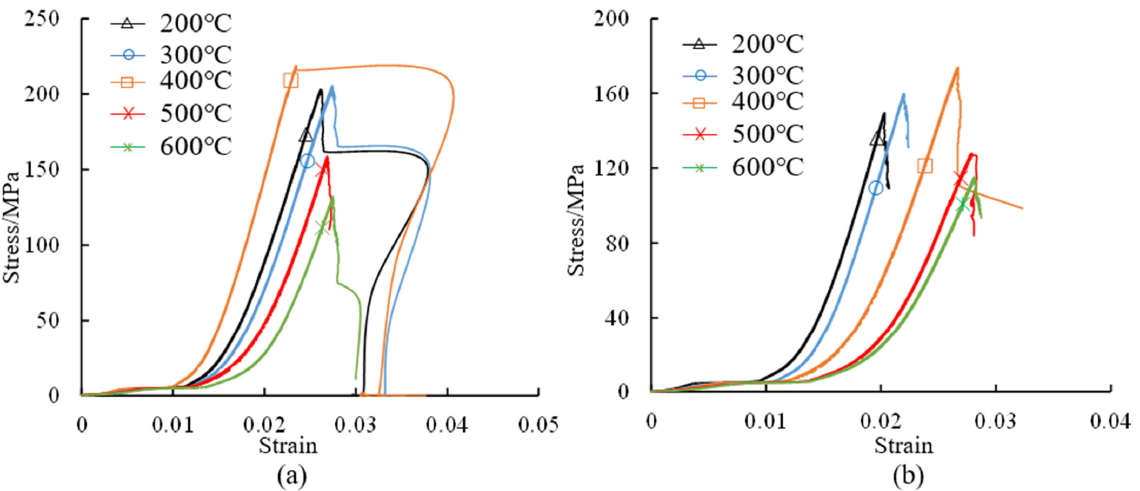
Figure 7. Stress–strain curves of samples under different cooling methods. ( a ) The stress–strain curve of the sample in natural cooling mode; ( b ) The stress–strain curve of the sample cooled in